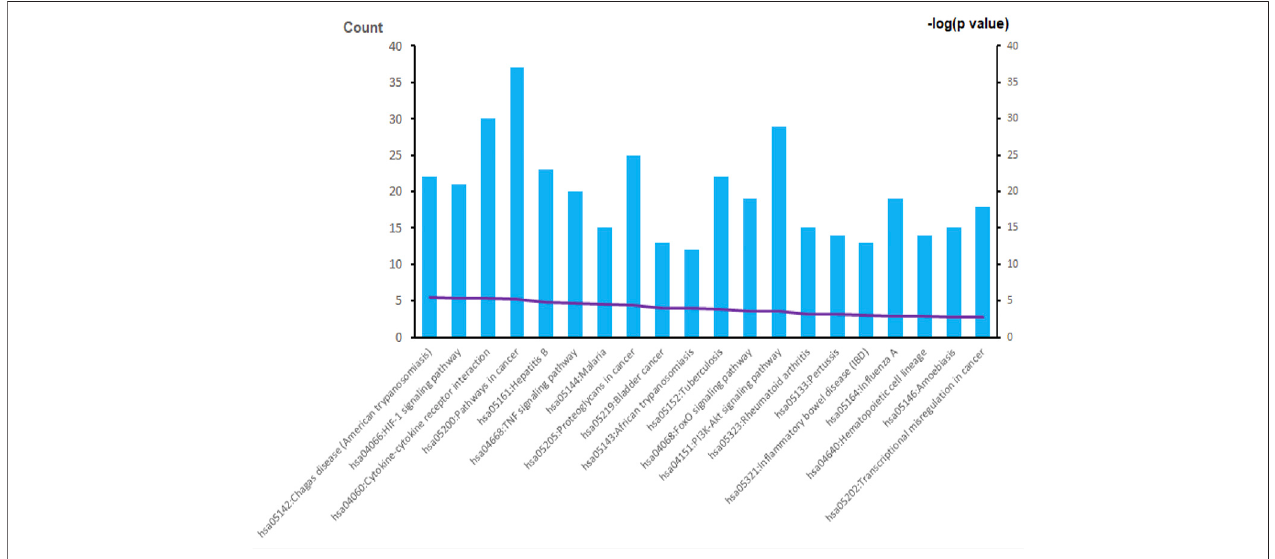
FIGURE 4 | The results of KEGG enrichment analysis. A total of 20 KEGG signaling pathways of overlapping genes are shown. KEGG, Kyoto Encyclopedia of Genes and Genomes.